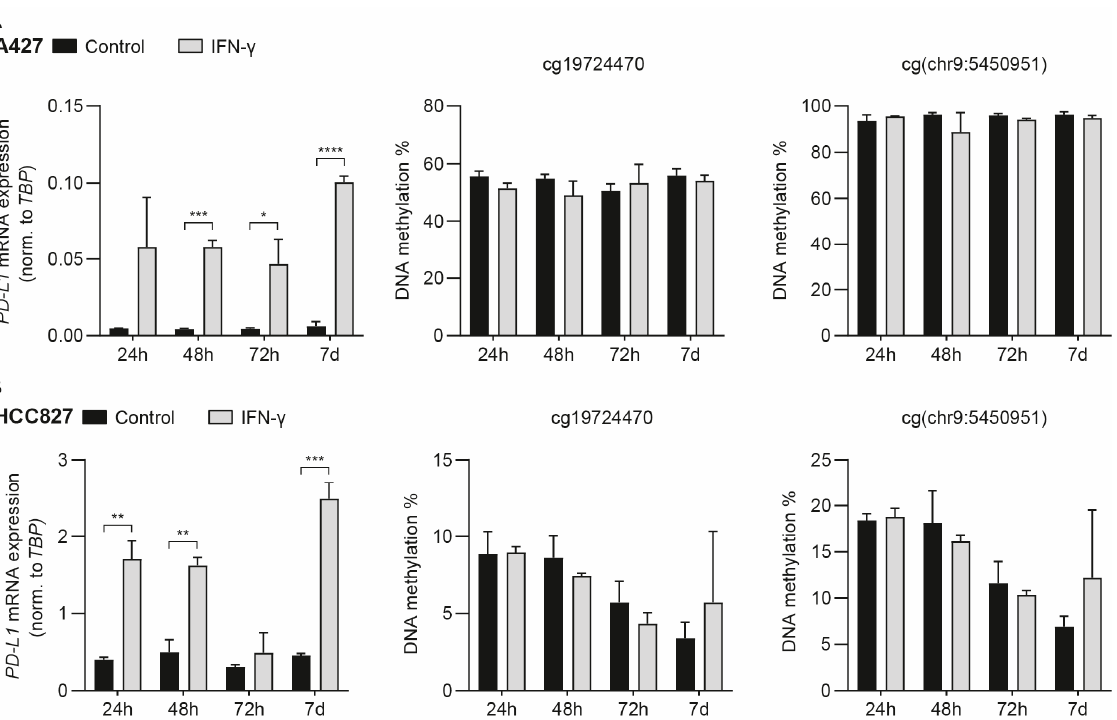
Figure 2. PD-L1 methylation and mRNA expression following interferon- γ (IFN- γ ) induction. (A) A427 cells and (B) HCC827 cells were stimulated with 10 ng/mL IFN- γ for 24h, 48h, 72h, or 7 days. PD-L1 mRNA expression was normalized to TBP . DNA methylation of cg19724470 and cg(chr9:5450951). Mean ± SD. n = 3 (except for the A427 control and IFN- γ at 24 h, where n = 2). Differences between the control and IFN- γ treatment were tested through an unpaired t -test with correction for multiple comparisons using the Holm–Šidák method. Adjusted p -value * < 0.05; ** < 0.01; *** < 0.001; **** < 0.0001.